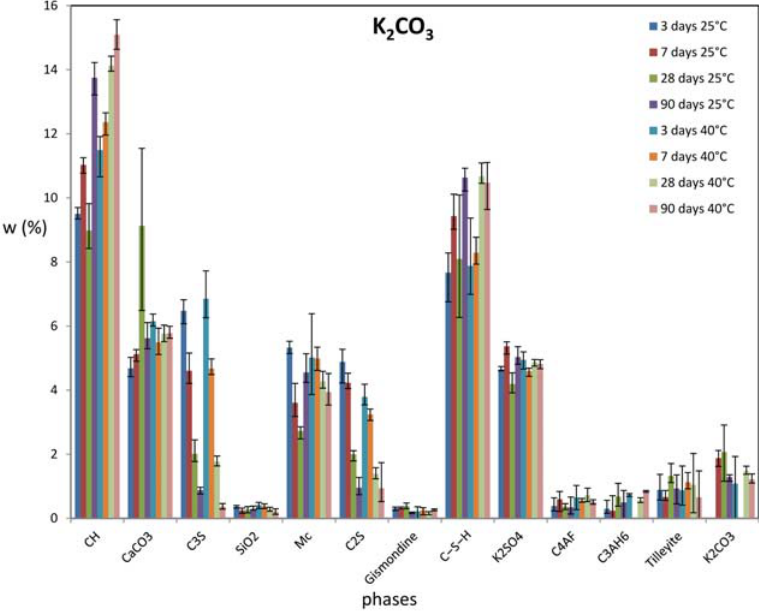
Figure 9. The quantitative analysis of hydration products in cements with added K 25 and 40